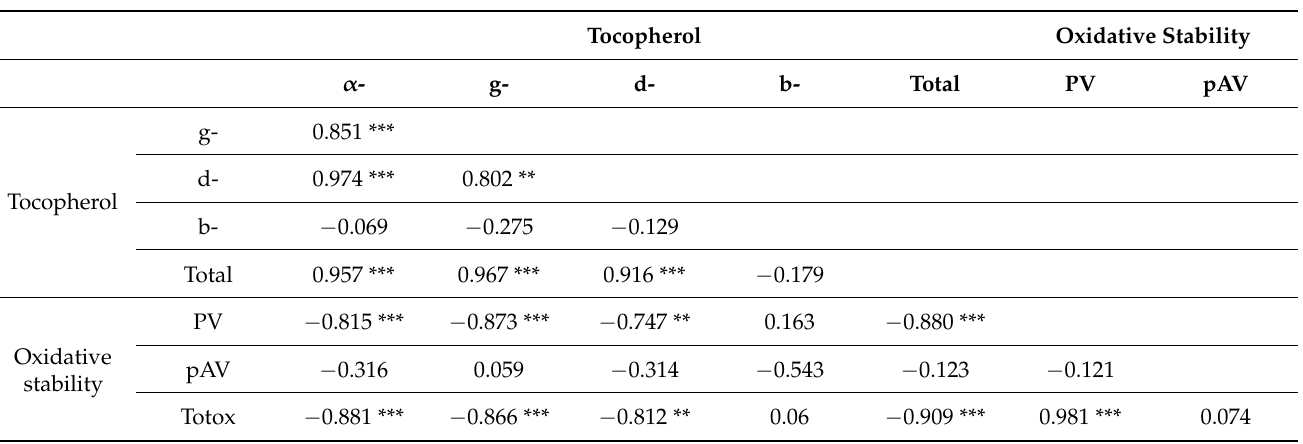
Table 3. Correlation coefficients between tocopherol contents and oxidative stability parameters collected from cottonseed butter samples B15 and B30 over the accelerated oxidation storage at 60 ◦